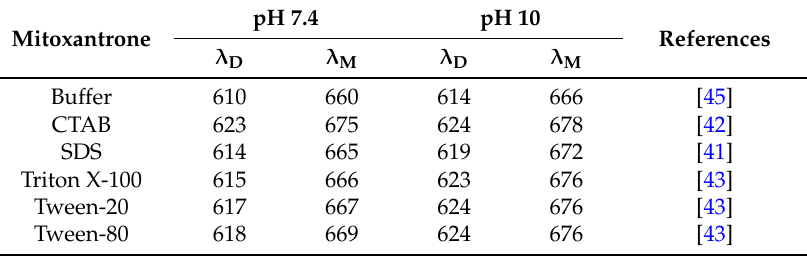
Table 1. Absorption maxima of dimer— λ D , and monomer— λ M of mitoxantrone in the absence and